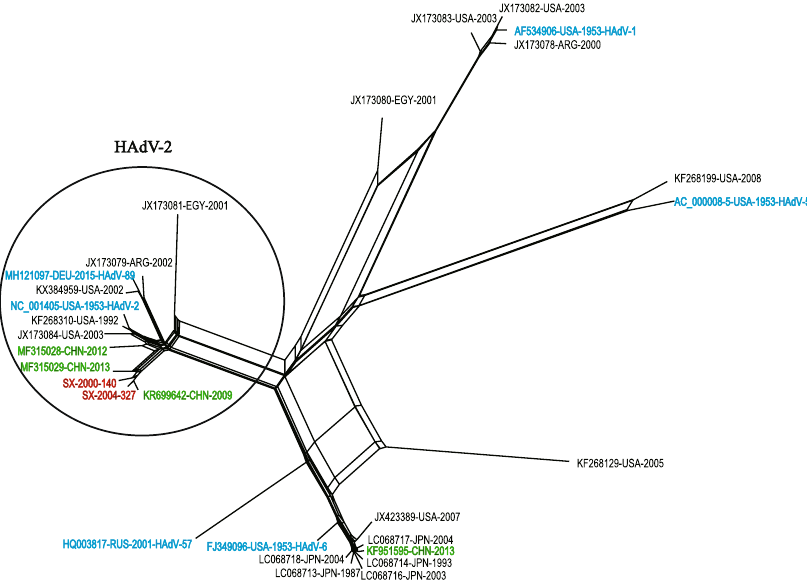
Figure 2. Phylogenetic network generated based on WGS of 29 HAdV-C strains. Red color indicates the two virus strains in this study; green color indicates the Chinese HAdV-C strains downloaded from the GenBank database; blue color indicates the prototype stains of six HAdV-C types, namely, HAdV-1, HAdV-2, HAdV-5, HAdV-6, HAdV-57, and HAdV-89. The fit index for the network was